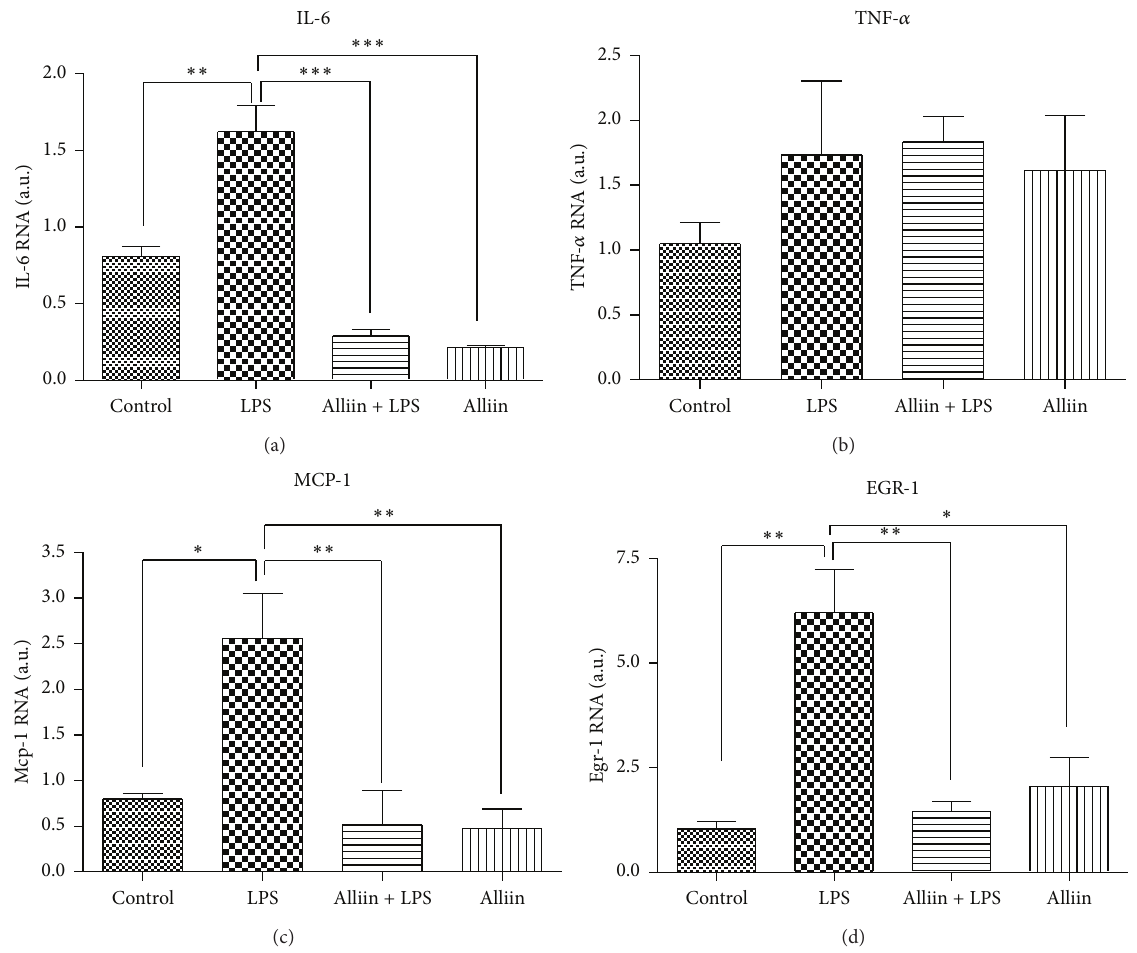
Figure 1: Messenger RNA (mRNA) expression levels of proinflammatory genes. Differentiated adipocytes were incubated with 0.1mM/mL alliin for 24 h and stimulated with 100ng/mL of lipopolysaccharides (LPS) for 1h. Values are expressed as arbitrary units (AU) after normalization of expression levels against a control gene. Results are mean ± standard deviations (SD) of three independent experiments. ∗ 𝑃 ≤ 0.05 ; ∗∗ 𝑃 ≤ 0.01 ; ∗∗∗ 𝑃 ≤ 0.001 .